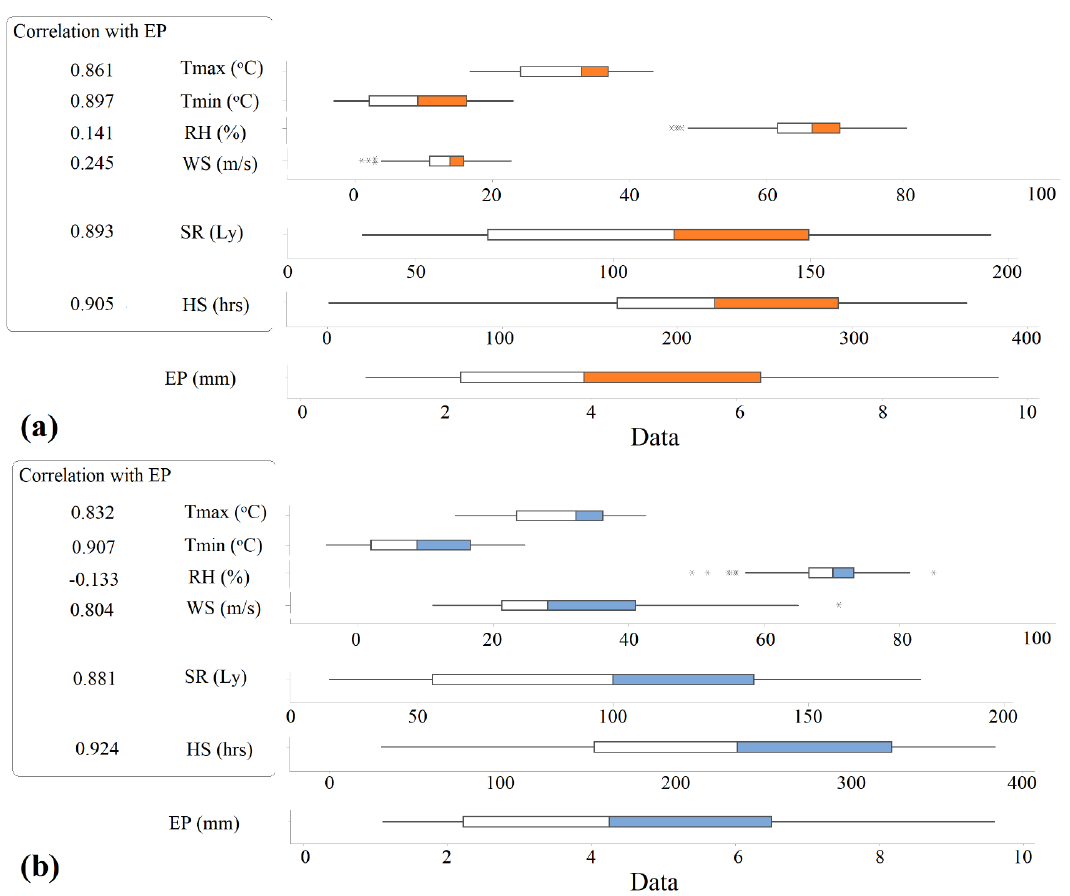
Figure 2. Box-plots of independent variables and EP for ( a ) Adana ( b ) Antakya Stations. The Pearson correlation coefficient was applied to analyze the effects of Tmax, RH, WS, SR, and HS on EP. It can be seen from Figure 2 that there were high correlations between EP, Tmin, Tmax, SR, and HS for both Stations. It is worth noting that the wind speed showed high correlation with EP for the Antakya Station (correlation = 0.804),